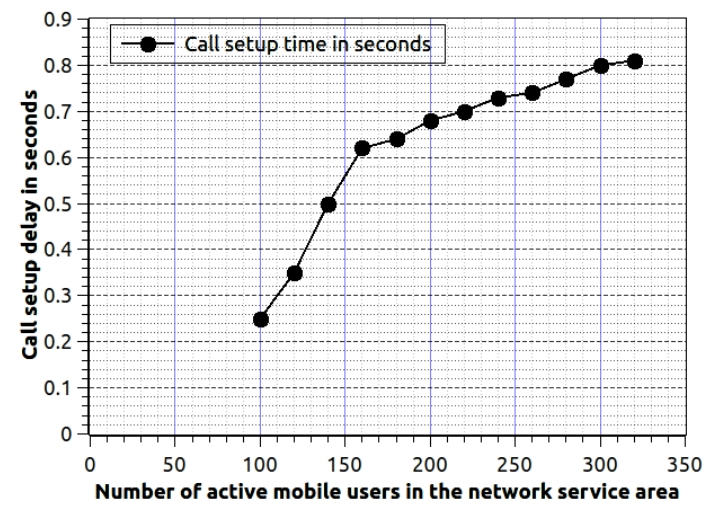
Figure 7. Number of active mobile users in the network service area verses call setup delay, where λ i = 0.01, µ i = 0.001 and δ t = 120 s.